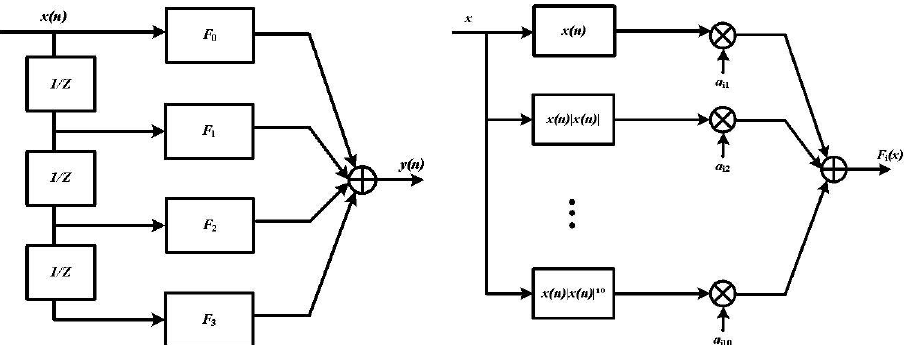
Figure 3. Block diagram of MP model.